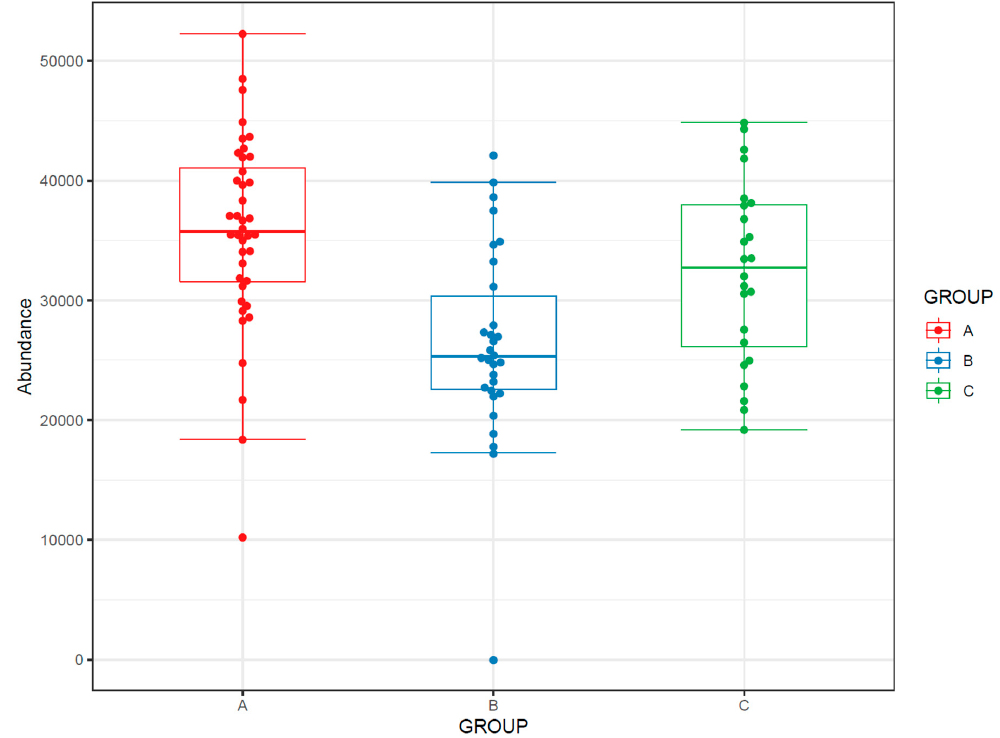
Figure 14. Beeswarm boxplots for a molecular feature subdivided into study group.